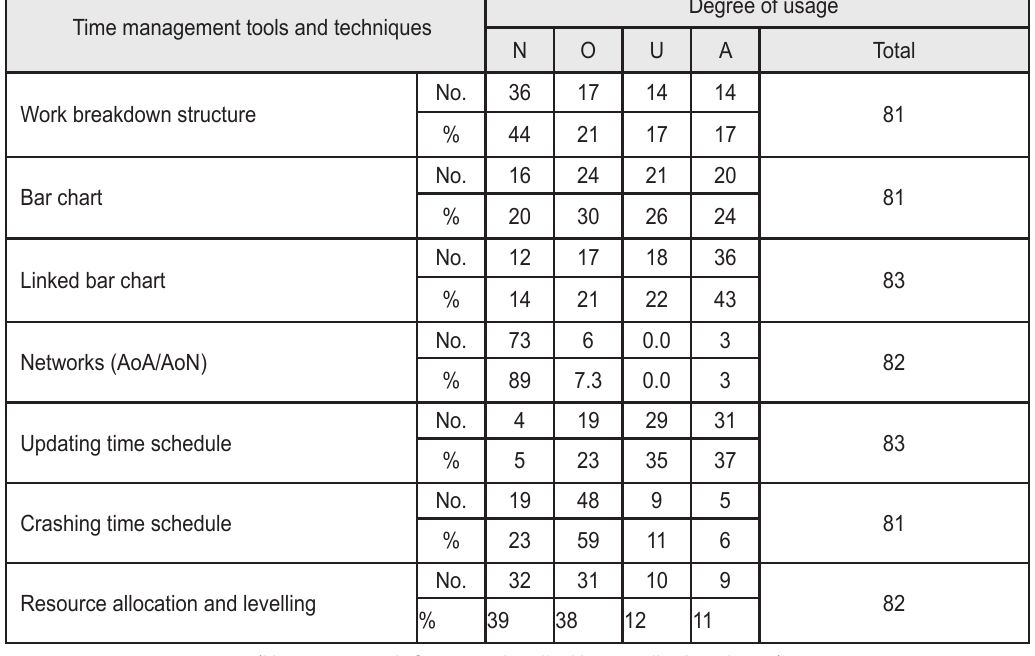
Table 2: Degree of using time management tools and